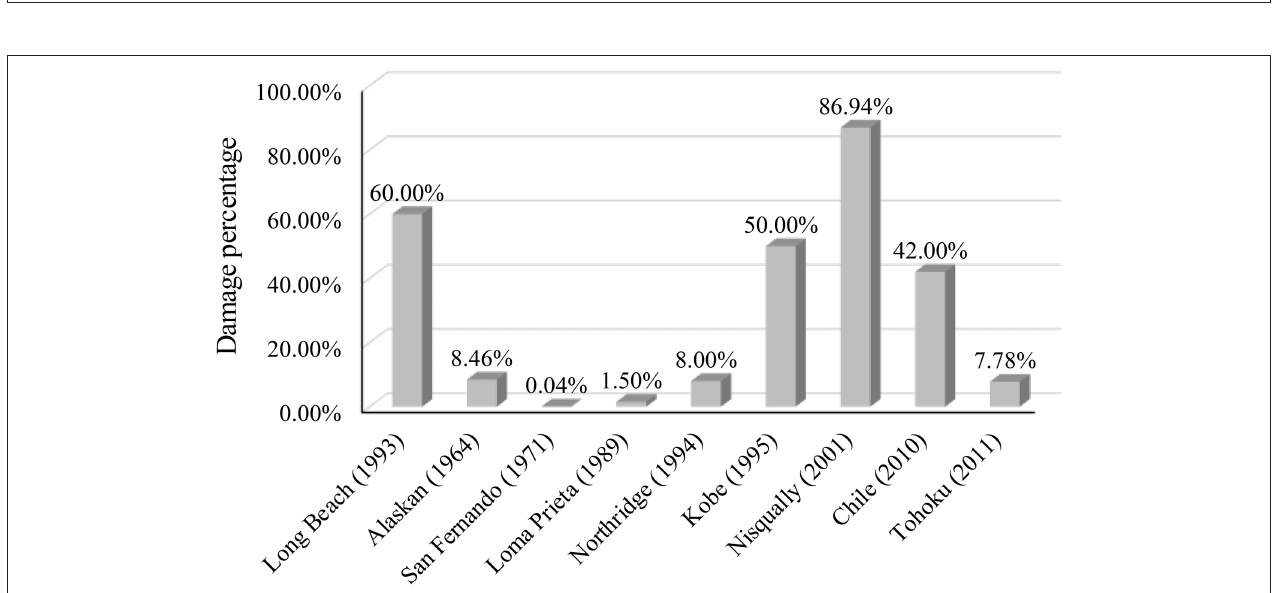
FIGURE 1 | Fractured piping tee joint at the Santiago Airport after the 2010 Chile earthquake.